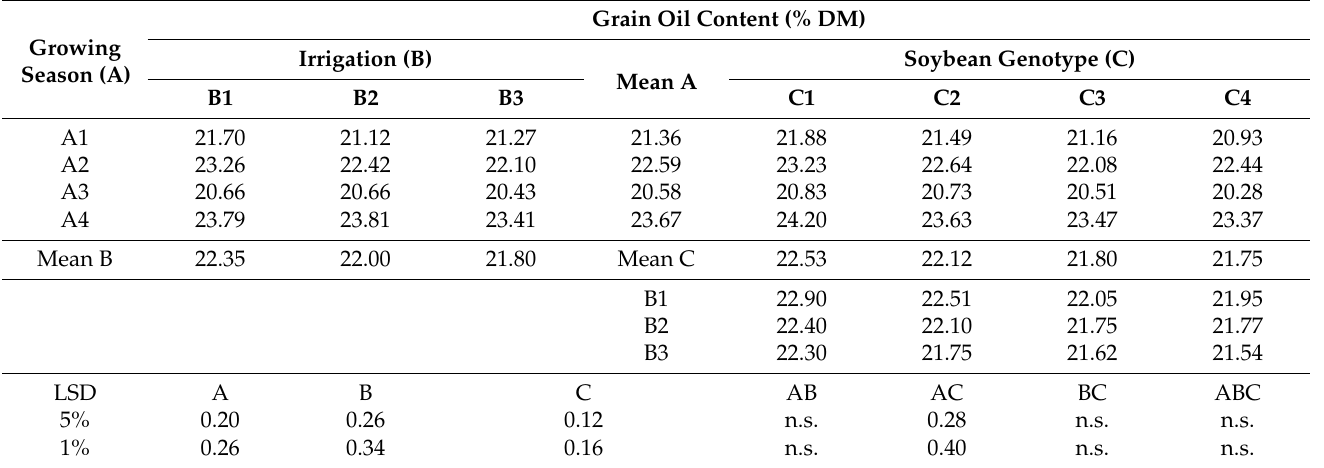
were found between B2 and B3 for all of the genotypes except for C4 (Table 6). The highest crude oil yield increase was determined for C1, 22.8% for C1B2 and 32% for C1B3 compared with C1B1. C2 had a 19.5% higher crude oil yield in C2B2 and a 14.6% higher crude oil yield in C2B3 compared to C2B1. The crude oil yield increase was less for C3 and C4 (Table 6). Table 5. Impacts of the environmental conditions in the four growing seasons (A1–A4), three treatments (B1, rain-fed conditions; B2, 60% of the field water capacity, or FWC; B3, 80–100% of the FWC), four genotypes (C1–C4) and their interactions (AB, AC, BC and ABC) on soybean grain oil contents (% dry matter, or DM). n.s. = not significant.